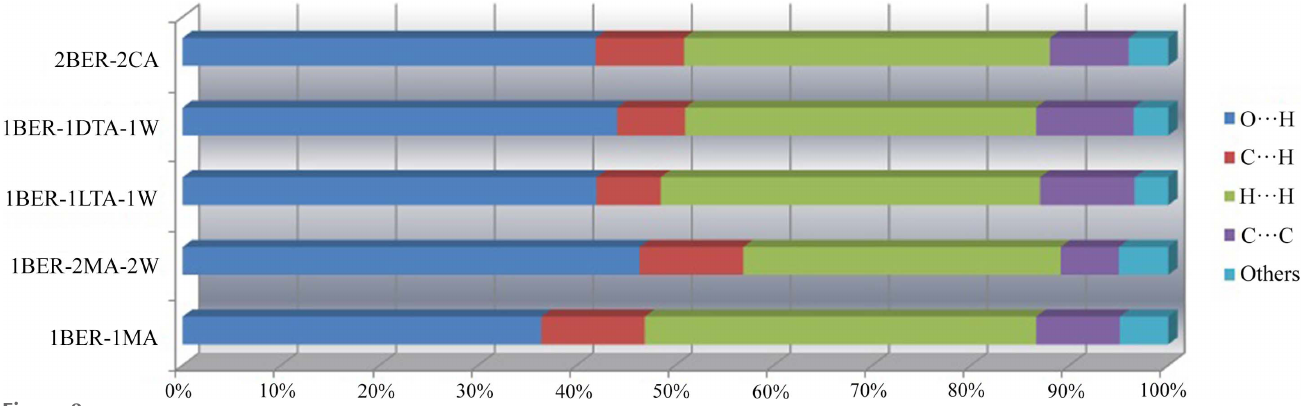
Figure 8 Summary of intermolecular interactions obtained from the Hirshfeld surface area for the five multi-component